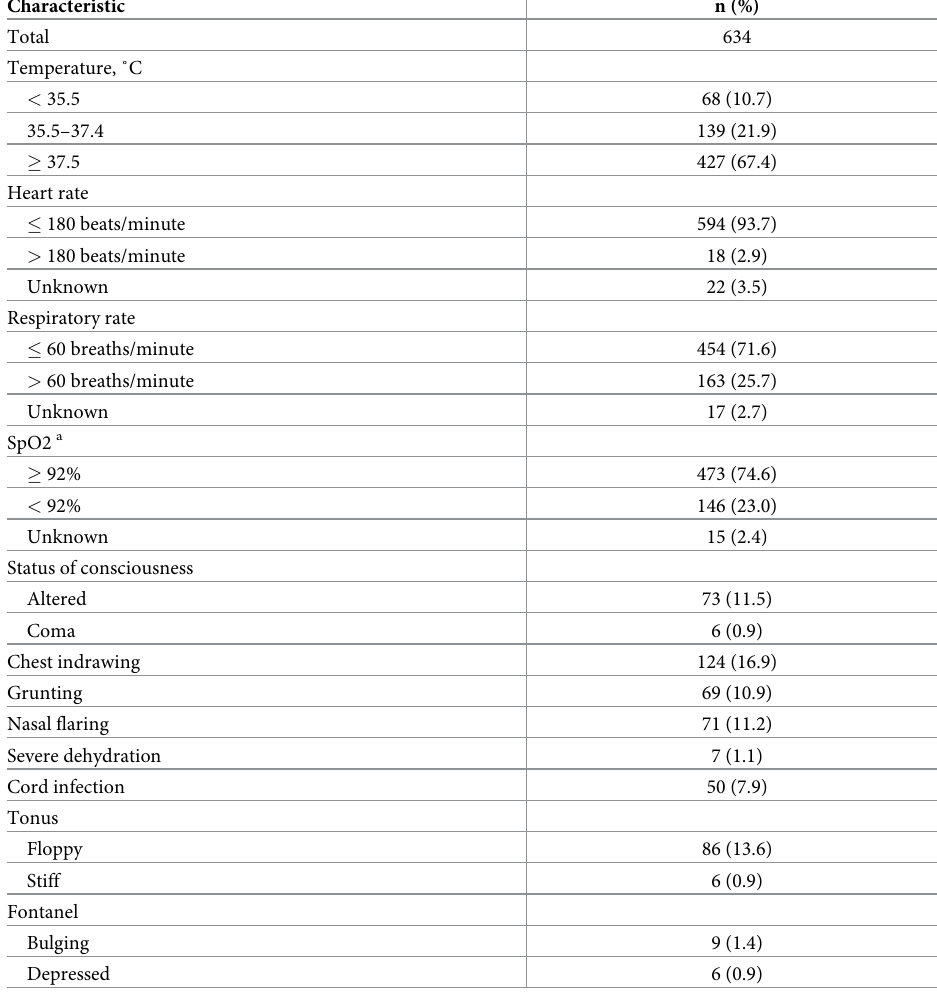
Table 4. Clinical presentation of young infants with clinically suspected invasive infection (clinical examination upon arrival at the